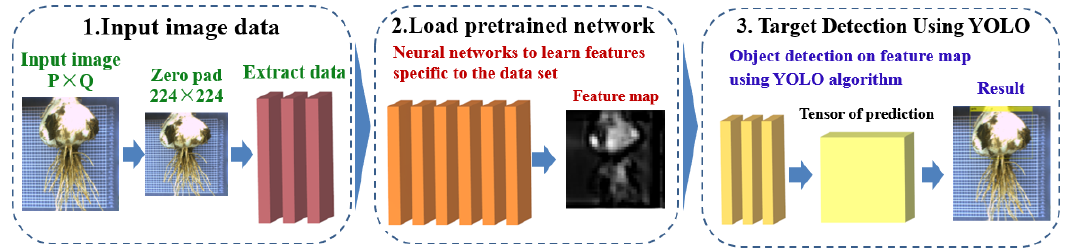
Figure 9. Pretrained network training. Table 2. Comparison of model structures.